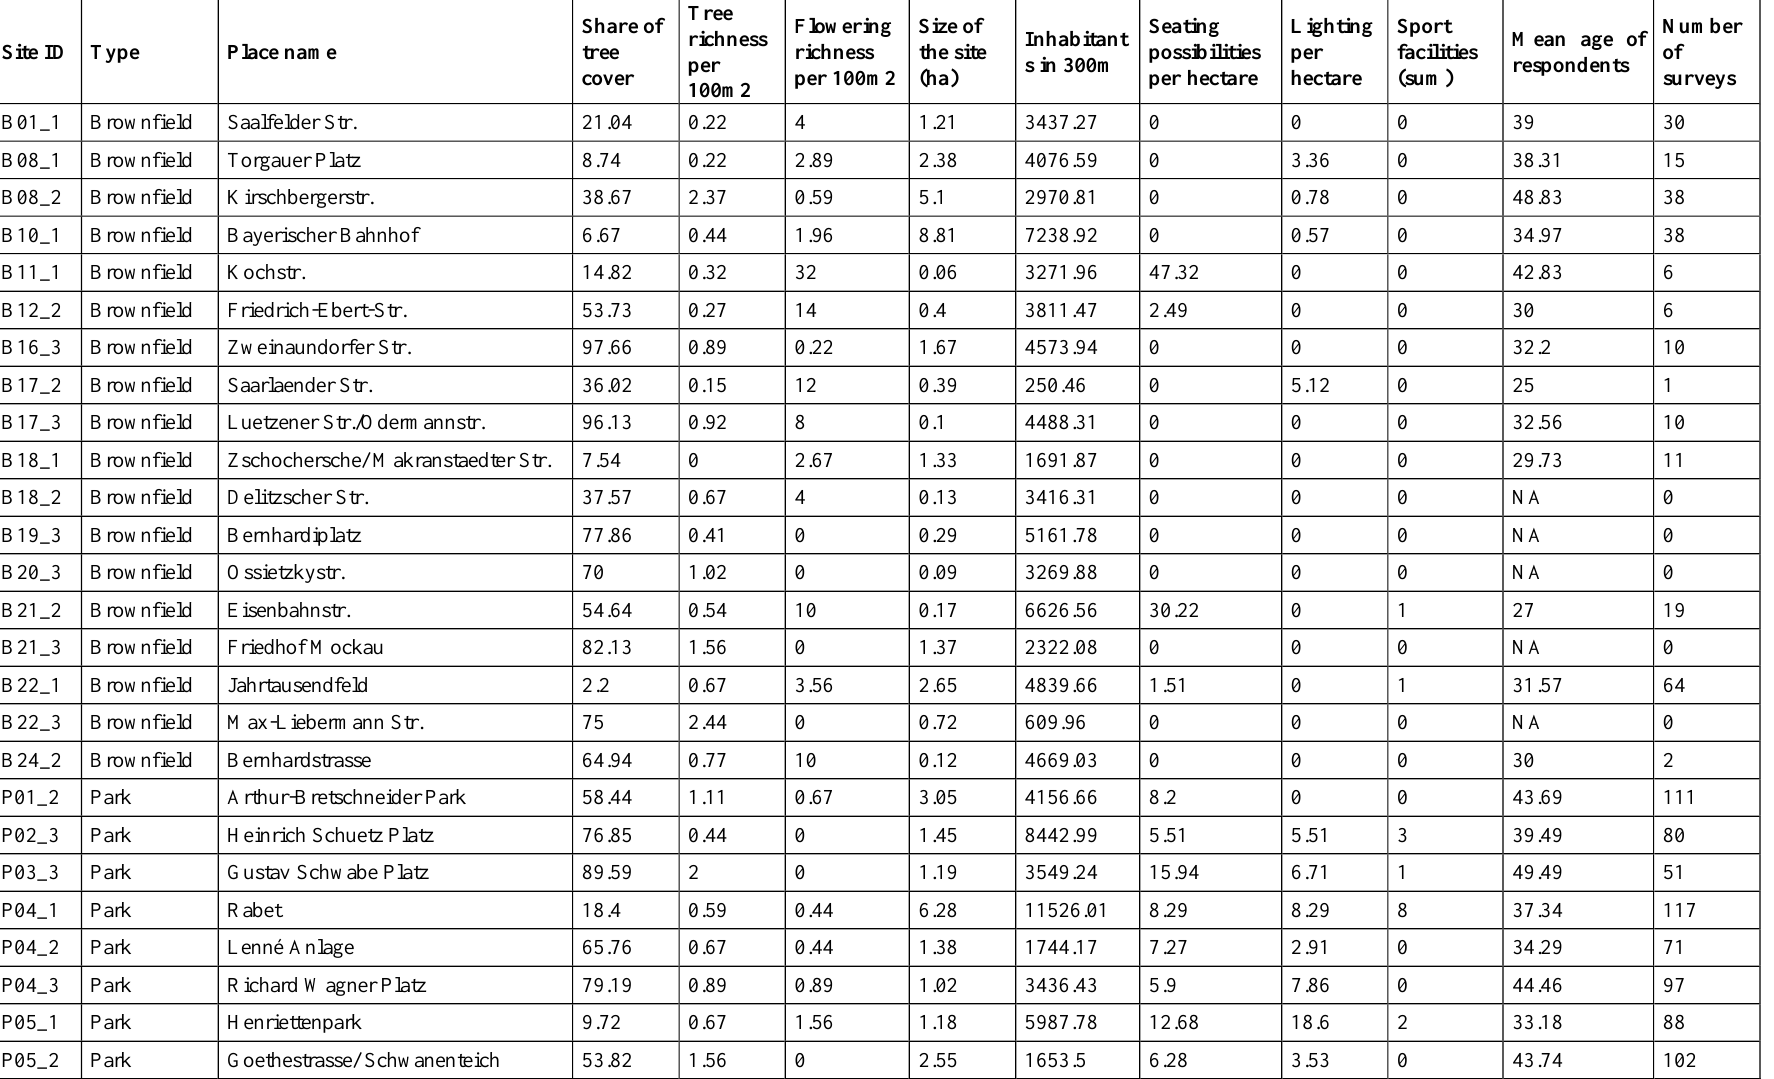
Table A1.1 : Green, spatial, and grey characteristics of study sites, mean age of respondents and number of conducted valid suryes.